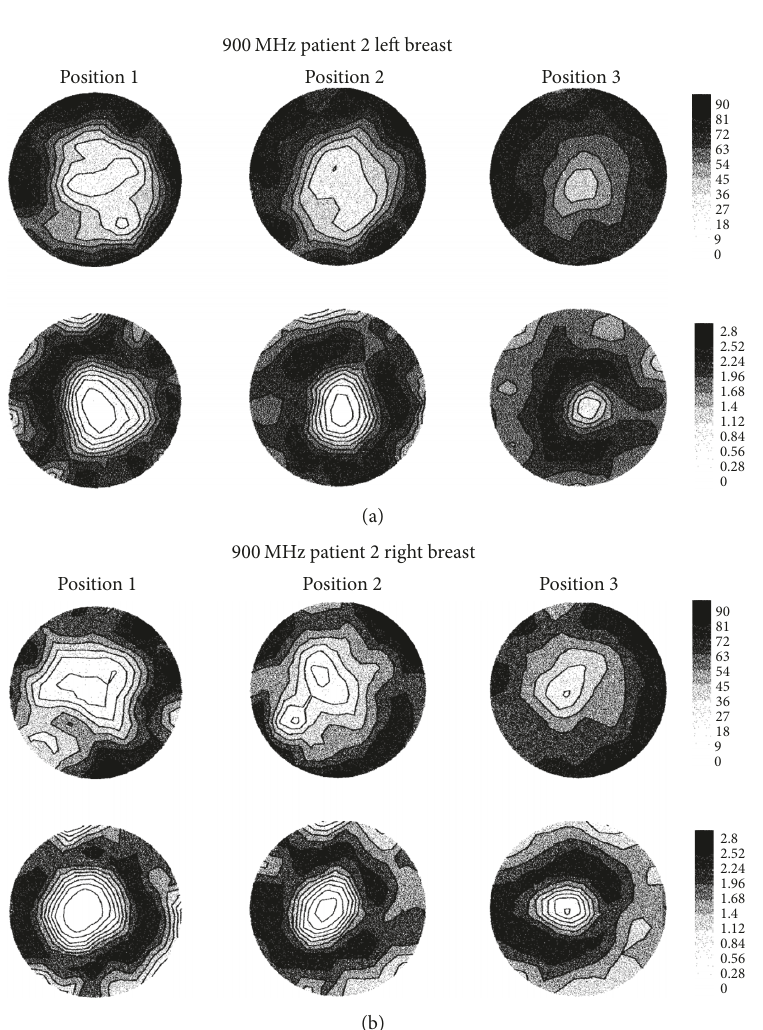
Figure 9: Recovered 900MHz relative permittivity and conductivity images from patient (a) left breast and (b) right breast [18]. Image copyright IEEE, used with